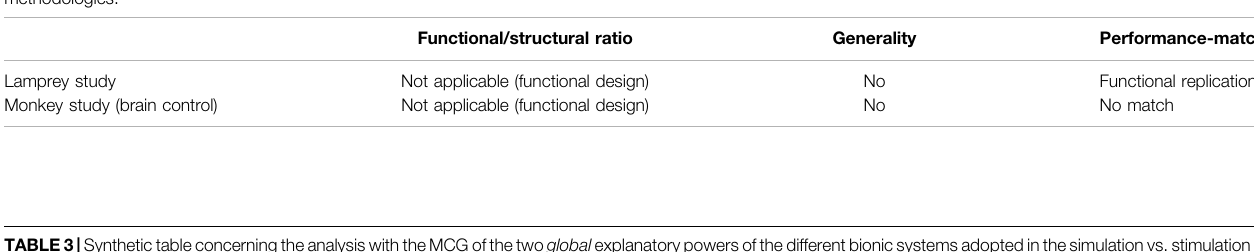
TABLE3| SynthetictableconcerningtheanalysiswiththeMCGofthetwo global explanatorypowersofthedifferentbionicsystemsadoptedinthesimulationvs.stimulation methodologies. Functional/structural